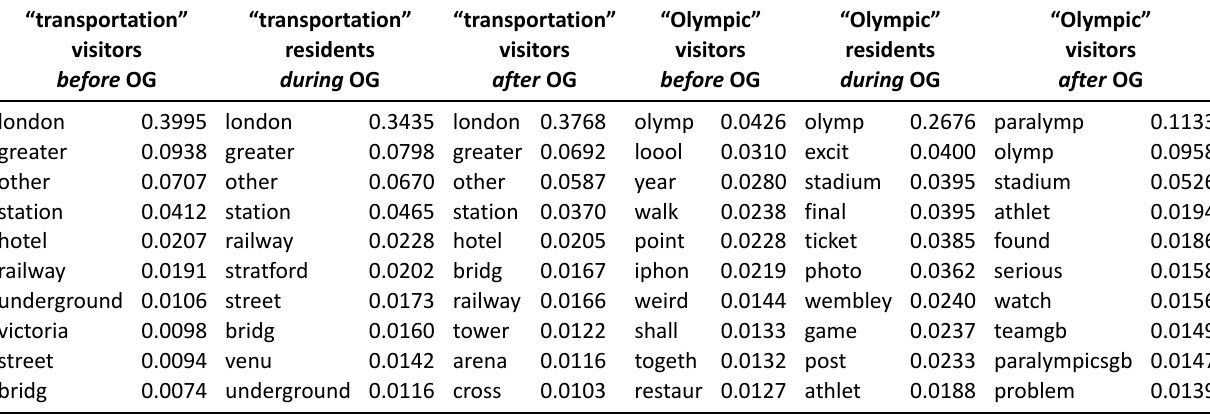
Table 3. Examples of words and their probabilities for the identified topics “Olympic” and “transportation”.